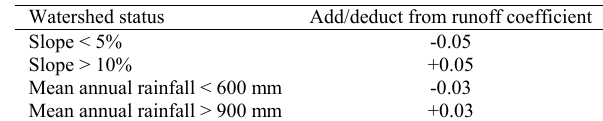
Table 2: Adjustment of runoff coefficient (c) in the rational approach for natural watersheds Watershed status